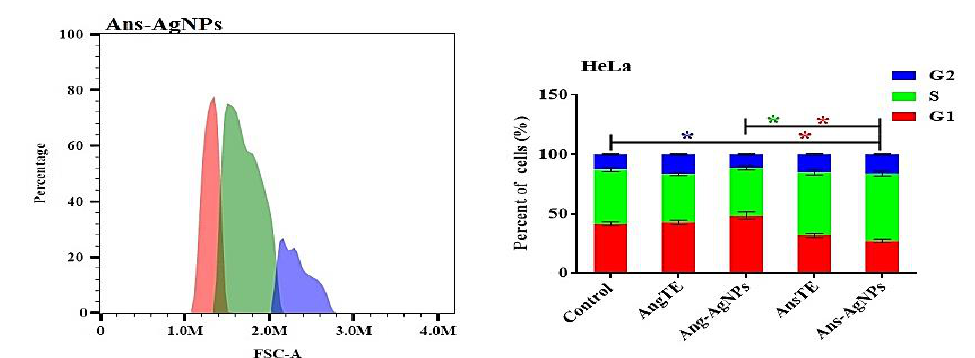
Figure 11. Effect of the extracts, AngTE, AnsTE, and their nanoparticles, Ang-AgNPs, and Ans- AgNPs, respectively, on cell cycle distributions of HeLa cells. Cell cycle distribution was determined using DNA cytometry analysis after exposure to AngTE, Ang-AgNPs, AnsTE, and Ans-AgNPs for 48 h. Data are presented as the mean ± SD; n = 3; G1, G2 and S are cell cycle phases, One-way ANOVA was used to test for statistical difference (* p < 0.05).